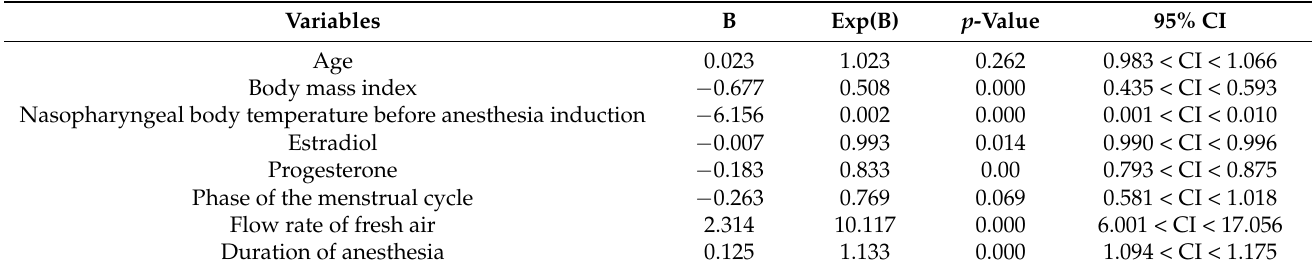
Table 6. Binary logistic regression analysis of risk factors for inadvertent intraoperative hypothermia after